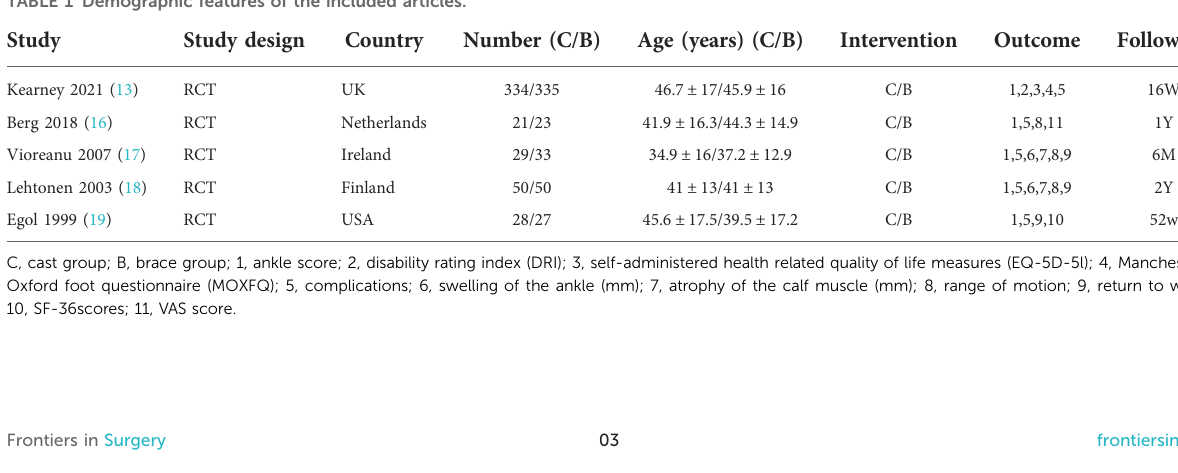
TABLE 1 Demographic features of the included